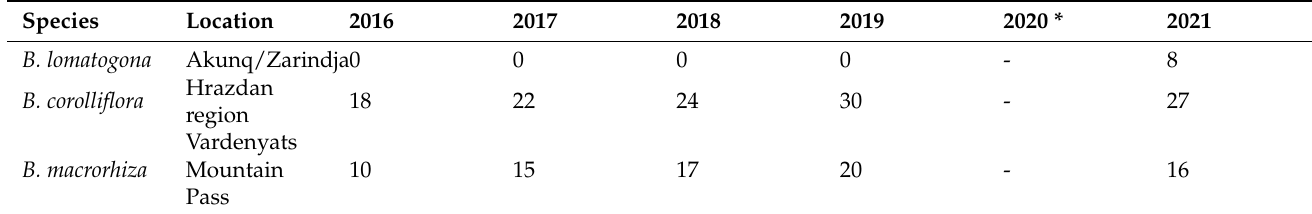
Table 2. Population size of the wild beet species in the selected locations in 2016–2021.